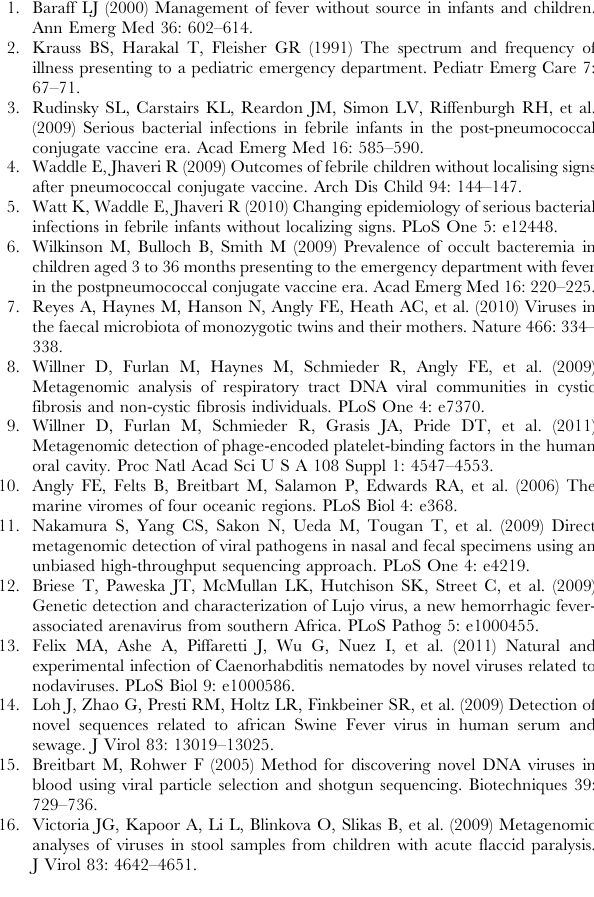
Figure S5 Detailed sequence statistics for each sample. Figure S6 Virus read counts for each sample. The numbers represent all alignments from cross_match and BlastX, not scaled to 3 million reads per sample. Only viruses with $ 1 read per 3 million sequences were used in comparisons between febrile and afebrile groups, so more viruses are listed here than in the text describing those